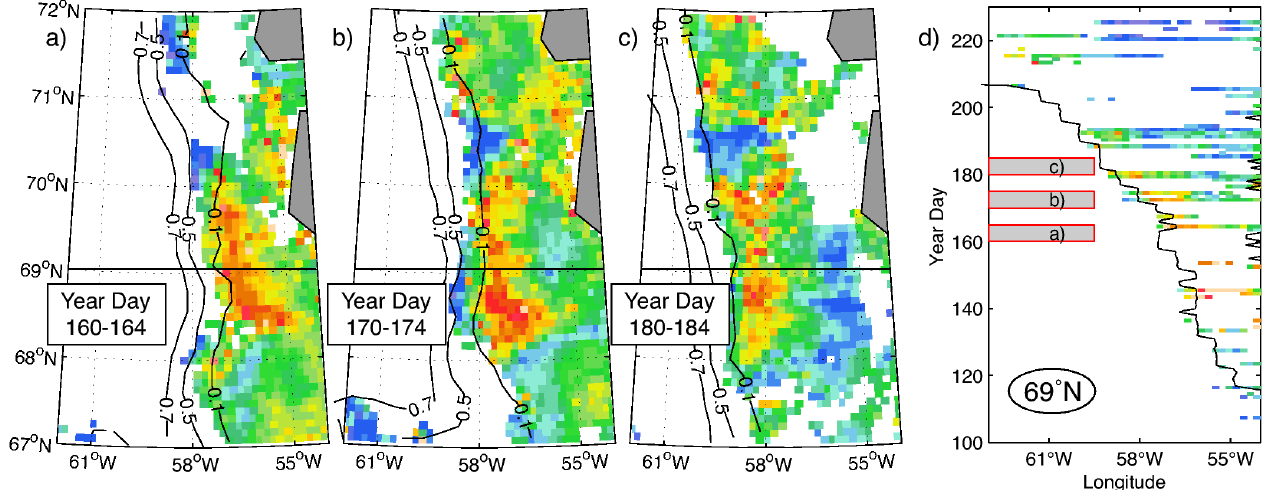
Fig. 3. An example of the propagation of an ice-edge phytoplankton bloom west of Greenland over a 25-day period (a, b, c) . The three images are 5-day composites of chlorophyll (SeaWiFS) overlaid with sea-ice contours (NSIDC) at 10%, 50% and 70%. White areas are missing chlorophyll data. Panel (d) shows a corresponding Hovm¨oller diagram at 69 ◦ N that illustrates the progression of the 2007 bloom, and shows that this can be followed for many months despite large data gaps. The black line indicates the 10% sea-ice contour. Colour code is the same as Fig.